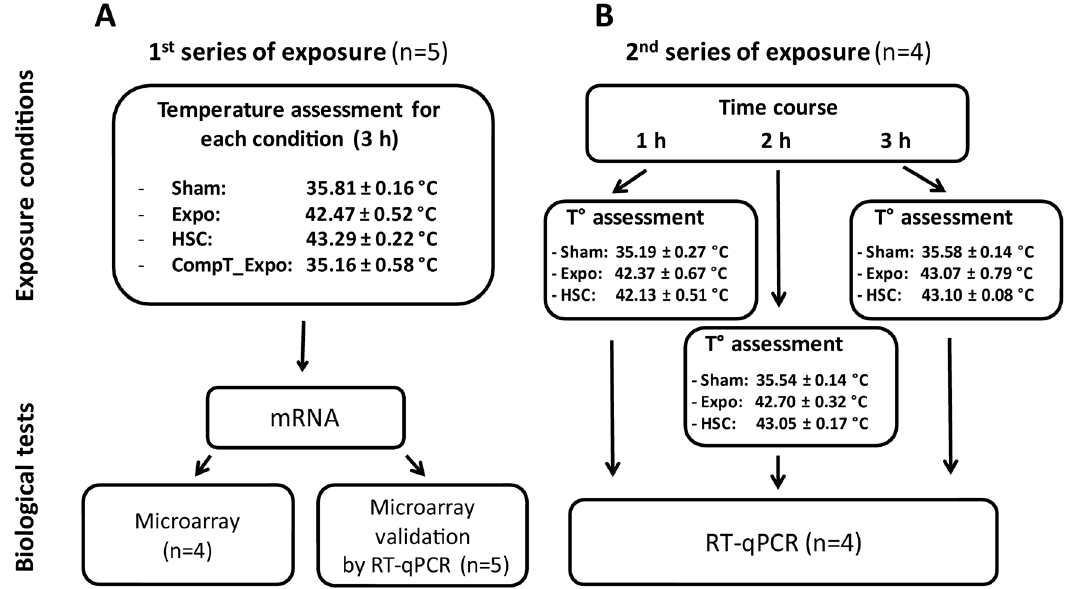
Figure 1. Experimental protocol. All experimental conditions are presented: 1) Control cells (Sham). 2) Cells exposed to MMW at 20 mW/cm 2 (Expo). 3) Heat shocked cells (HSC). 4) Cells exposed to MMW with temperature increase compensated (CompT_Expo). Average of steady-state temperature in the medium is obtained from the measurement of each experimental replicates ( u C, mean 6 SD). A) First series of exposure with 4 conditions that were used for the microarray experiment and for the RT-PCR validation. B) Second series of exposure with 3 experimental conditions (n=4) that are the duplication of the exposure, analysed by RT-PCR.